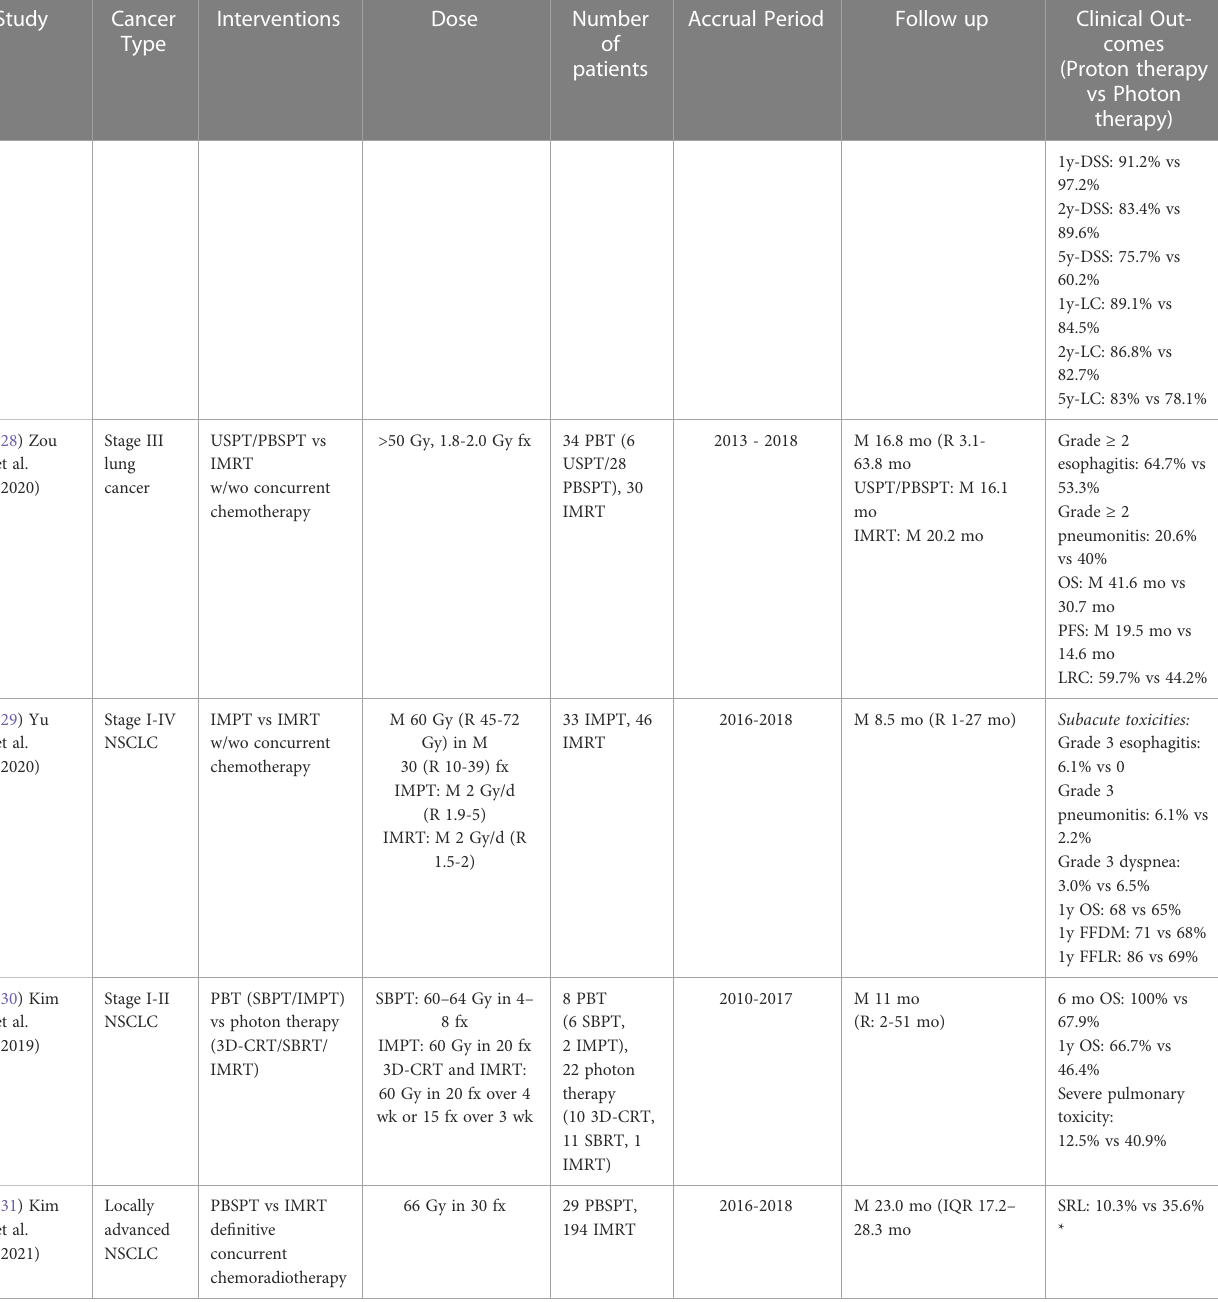
Alterio et al. (42) analyzed outcomes of stage T3-4N0-2 nasopharyngeal carcinoma patients and showed that patients treated with a PBSPT boost experienced signi fi cantly lower risk of acute grade 3 mucositis and acute grade 2 xerostomia. However, no statistical differences were found for late toxicities, local progression-free survival, progression-free survival and local control rate between groups (Table 5).